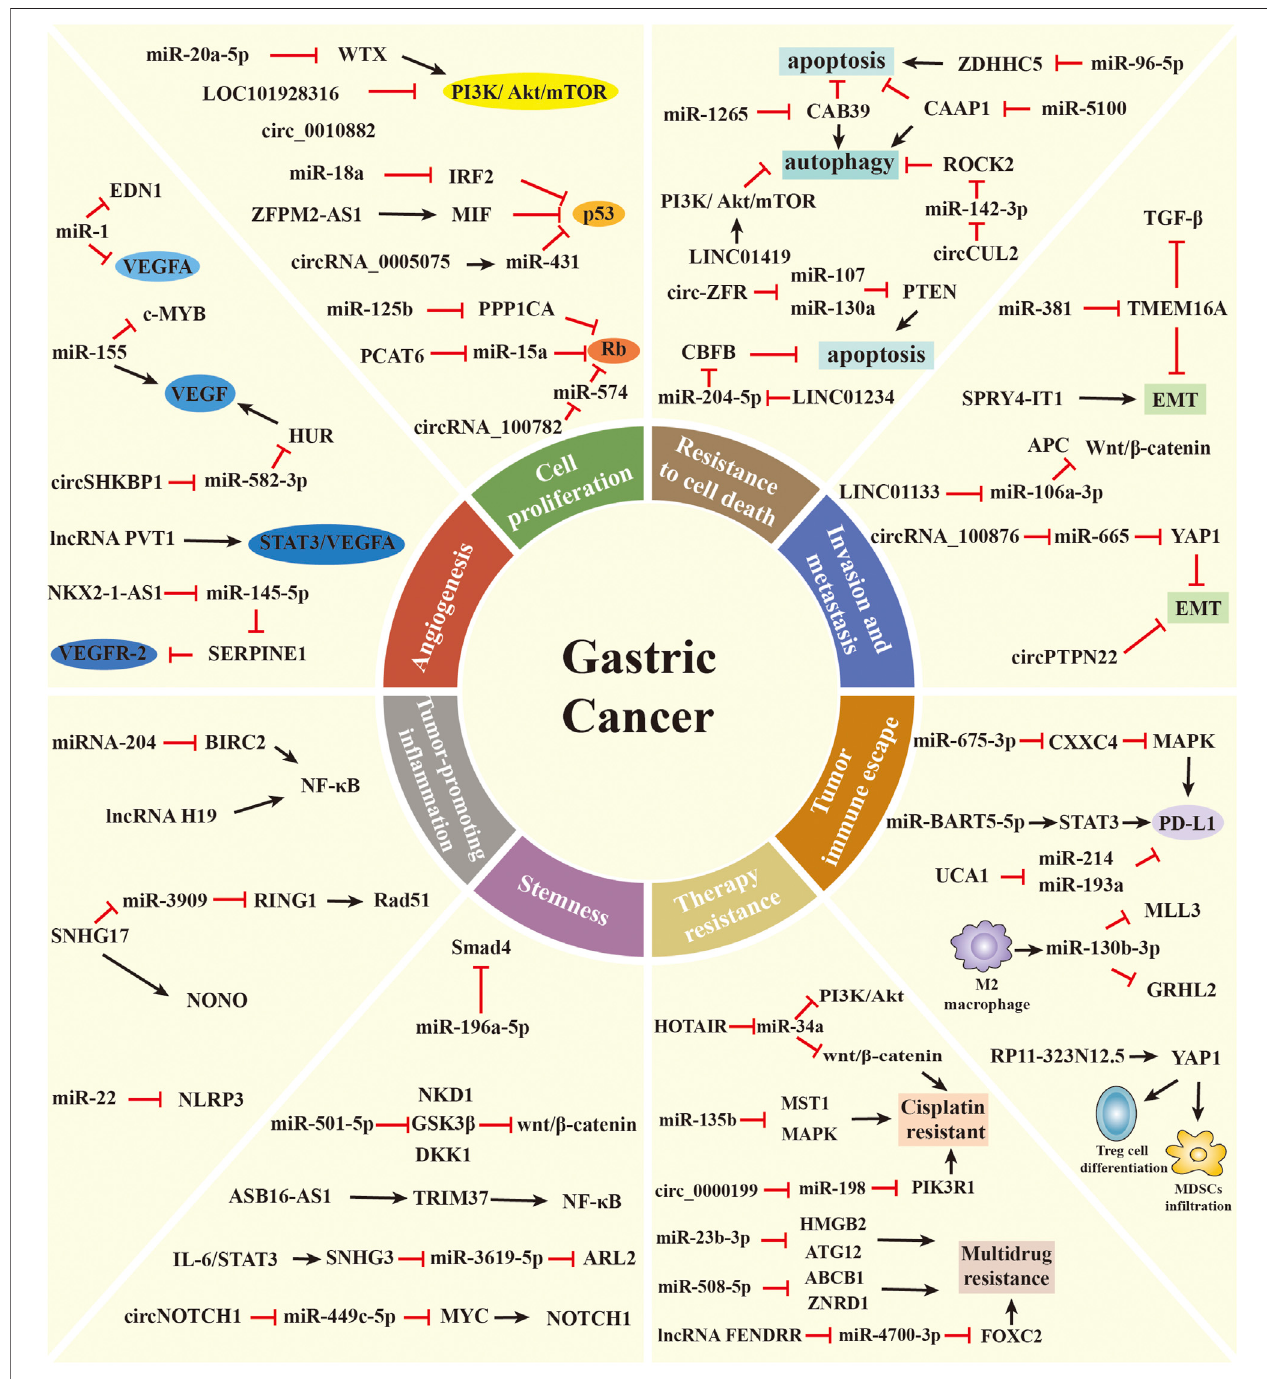
FIGURE 2 | The role of ncRNAs in regulating the malignant hallmarks of GC. Selected examples of ncRNAs and their molecular mechanisms in modulating the malignant hallmarks of GC, including cell proliferation, resistance to cell death, invasion and metastasis, angiogenesis, tumor-promoting in fl ammation, tumor immune escape, stemness, and therapy